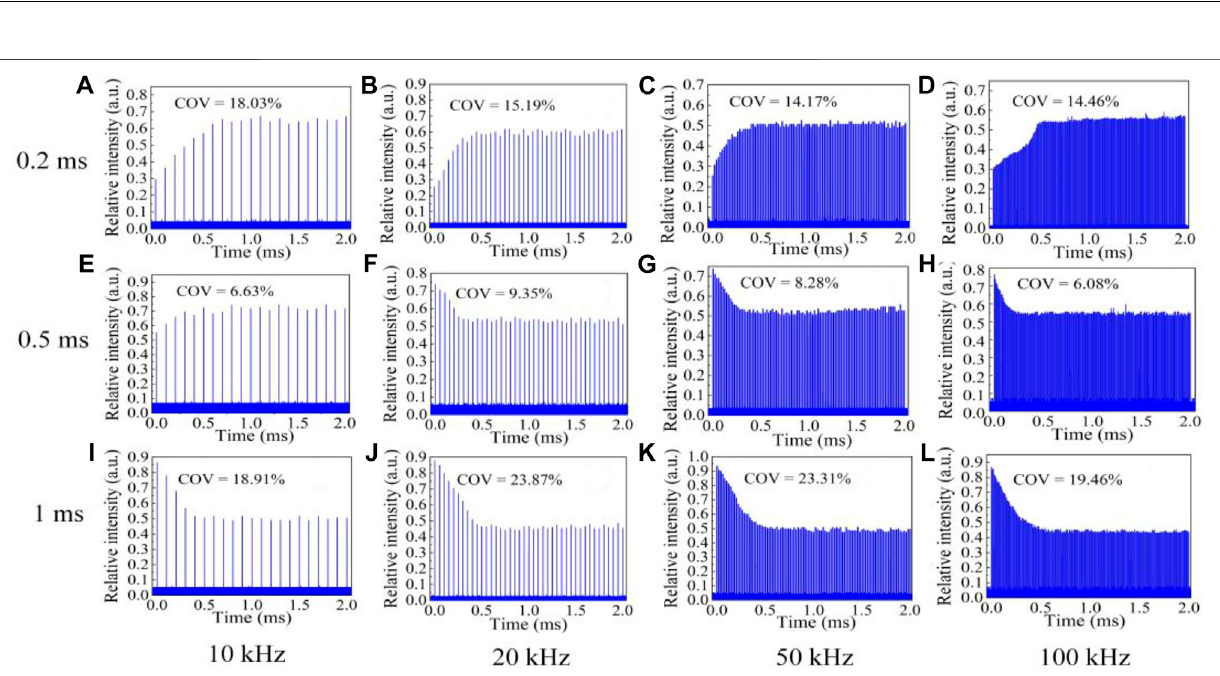
FIGURE6| Recorded pulse-burst distribution at differentpump time τ fordifferentrepetitionrates. (A) At10 kHzrepetitionrateforpumptime τ with0.2 ms. (B) At 20 kHzrepetition ratefor pump time τ with0.2 ms. (C) At50 kHz repetitionrate forpump time τ with0.2 ms. (D) At100 kHzrepetitionrate forpump time τ with0.2 ms. (E) At 10 kHz repetition rate for pump time τ with 0.5 ms. (F) At 20 kHz repetition rate for pump time τ with 0.5 ms. (G) At 50 kHz repetition rate for pump time τ with 0.5 ms. (H) At 100 kHz repetition rate for pump time τ with 0.5 ms. (I) At 10 kHz repetition rate for pump time τ with 1 ms. (J) At 20 kHz repetition rate for pump time τ with 1 ms. (K) At 50 kHz repetition rate for pump time τ with 1 ms. (L) At 100 kHz repetition rate for pump time τ with 1